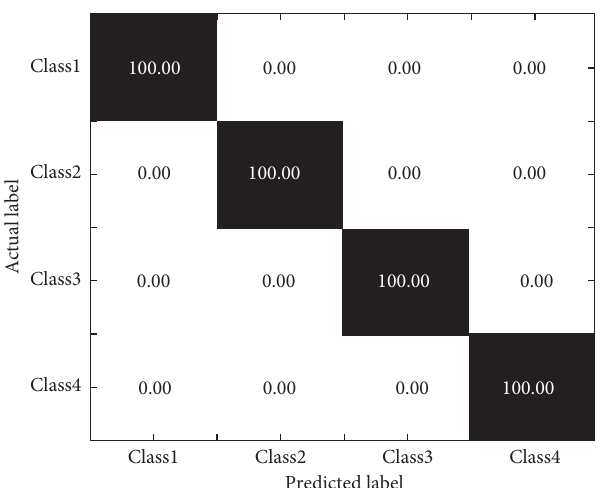
Figure 10: The confusion matrix of the result with VMD.